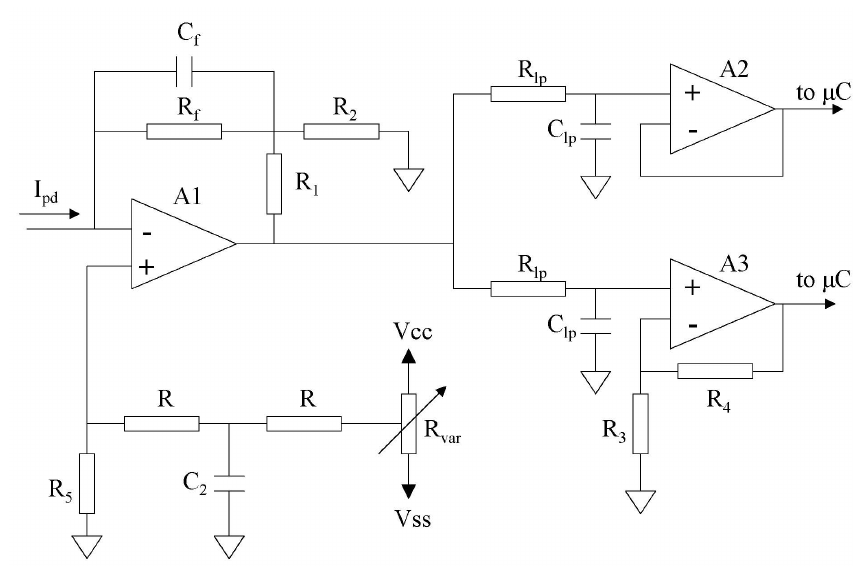
Figure 3. Measurement